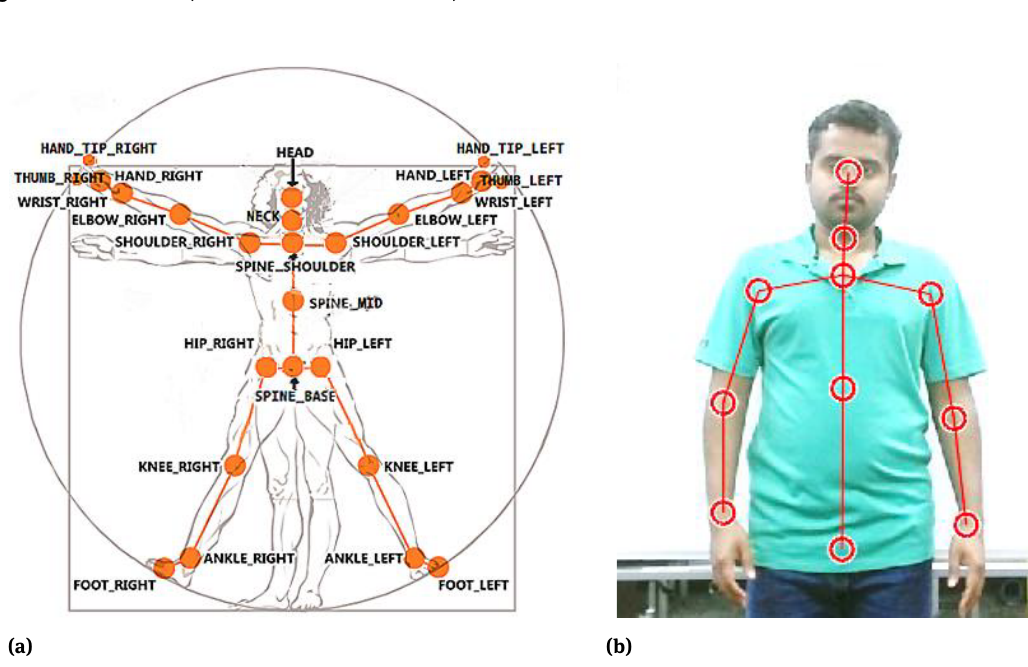
Figure 3: (a) Name of the tracked joints using Kinect [37]; (b). Kinect coordinate frames used in